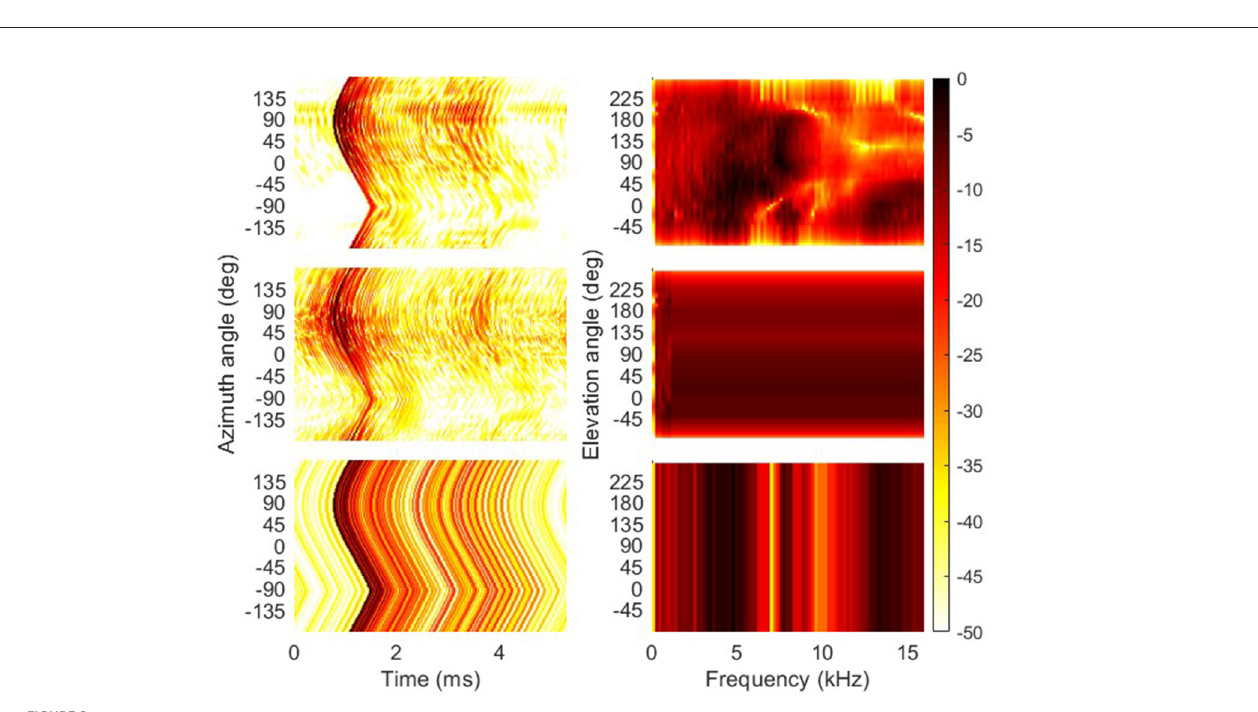
FIGURE2 HRTFs of the subject NH257 as an example. (Left column) Energy time curves of the impulse responses (in dB) calculated for the HRTFs of a left ear along the azimuth angle. (Right column) Magnitude spectra of HRTFs (in dB) along the median plane as a function of the polar angle. (Top row) HRTFs from the condition “full." (Center row) HRTFs from the condition “flat,” here the MSS was significantly flattened, but the time of arrival, thus, the ITD and dITD cues remained unchanged. (Bottom row) HRTFs from the condition “frozen" to (0 ◦ ,0 ◦ ), i.e., for all spatial positions, the MSS was frozen to that of the spatial position in the front and at eye level, but the time of arrival, thus, the ITD and dITD cues, were identical to those from the actual spatial